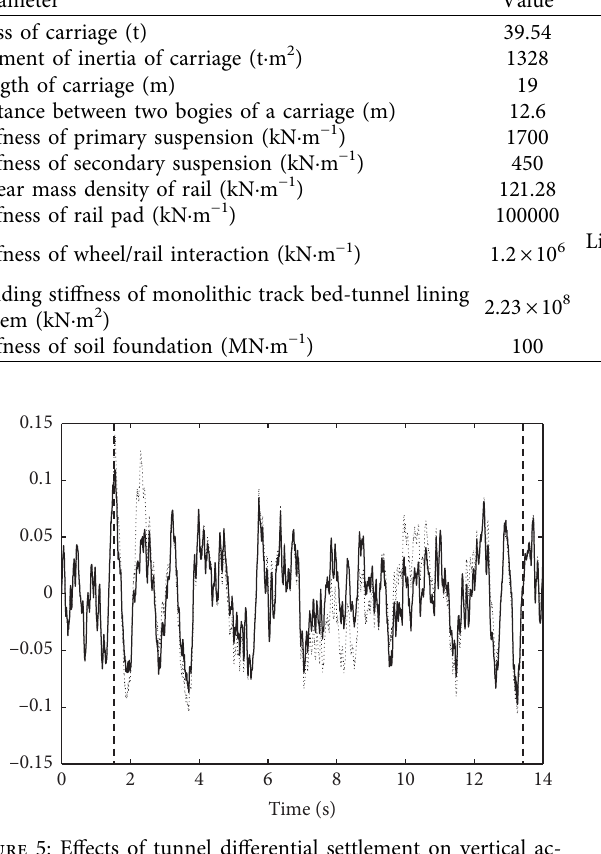
Figure 4: Differential settlement curves for a metro tunnel in southern China. (a) Measured curve of tunnel differential settlement. (b) Fitting differential settlement. Table 3: Material and geometric parameters of the metro train-monolithic track system. Parameter